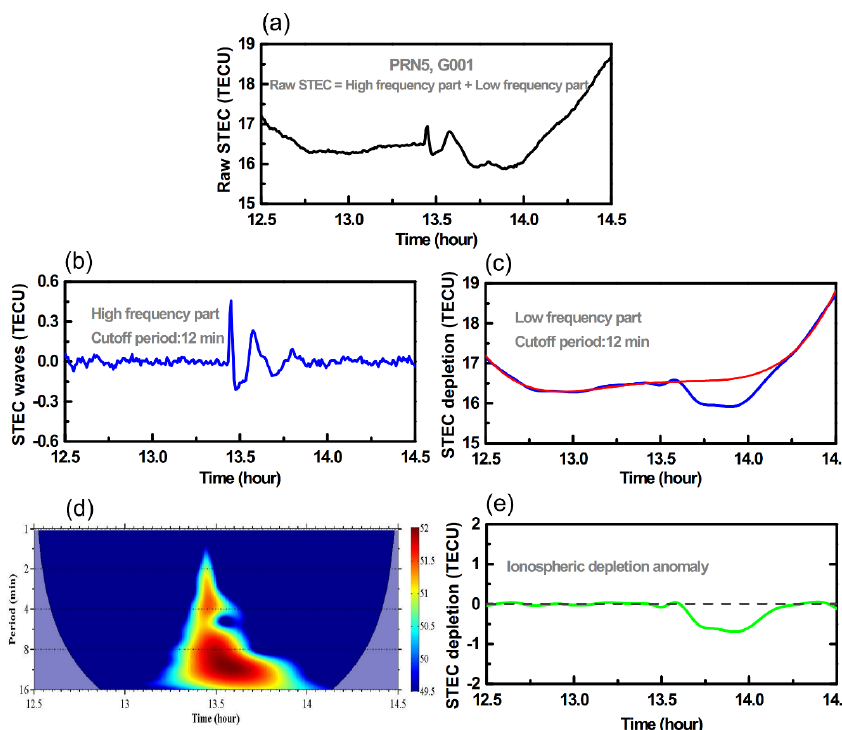
Figure 2. (a) The raw STEC time series of PRN05 at G001 station during 12:30–14:30UT on DOY 272 in 2011, (b) the high frequency part of filtered STEC time series by setting a cutoff period of 12min, (c) the low frequency part of filtered STEC time series by setting a cutoff period of 12min (blue solid line), the red solid line indicate the reference curve calculated by least squares polynomial fitting method, (d) the local continuous wavelet power spectrum variations of the high frequency part of filtered STEC time series, (e) the ionospheric depletion calculated between the low frequency part of filtered STEC time series and the reference